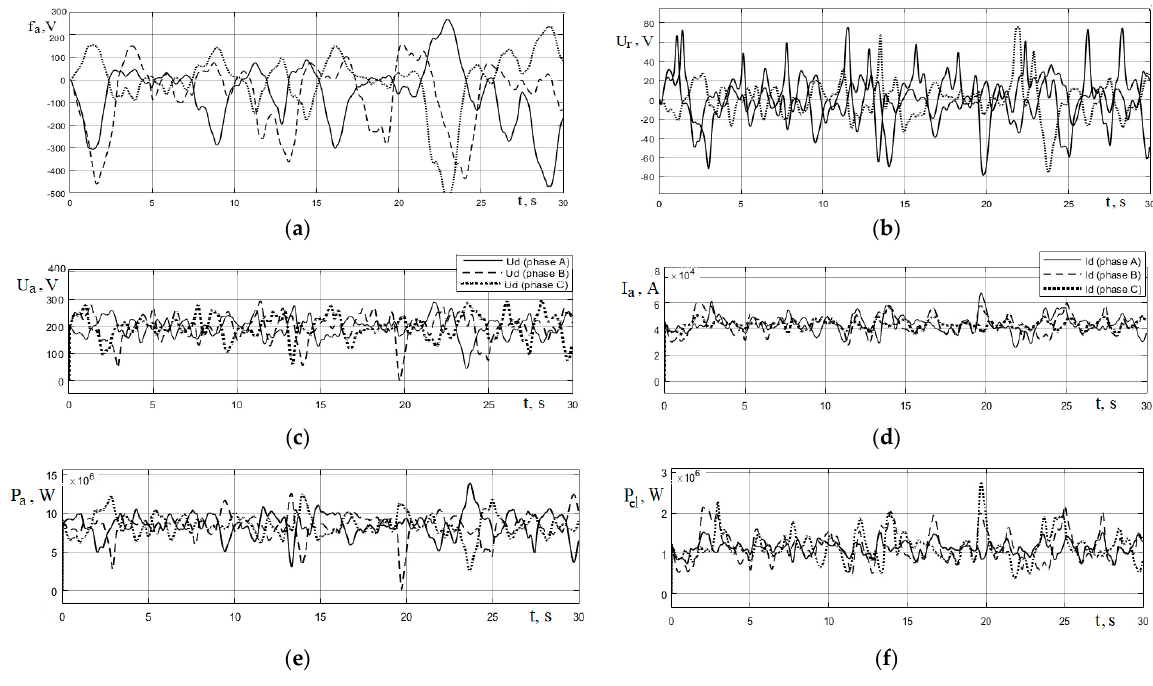
Figure 12. Time dependences of random perturbations: ( a ) mismatch signals; ( b , c ) voltages; ( d ) cur- rents; ( e ) power of arcs; ( f ) power of electric losses when using fuzzy model (6) for first technological stage of melting.